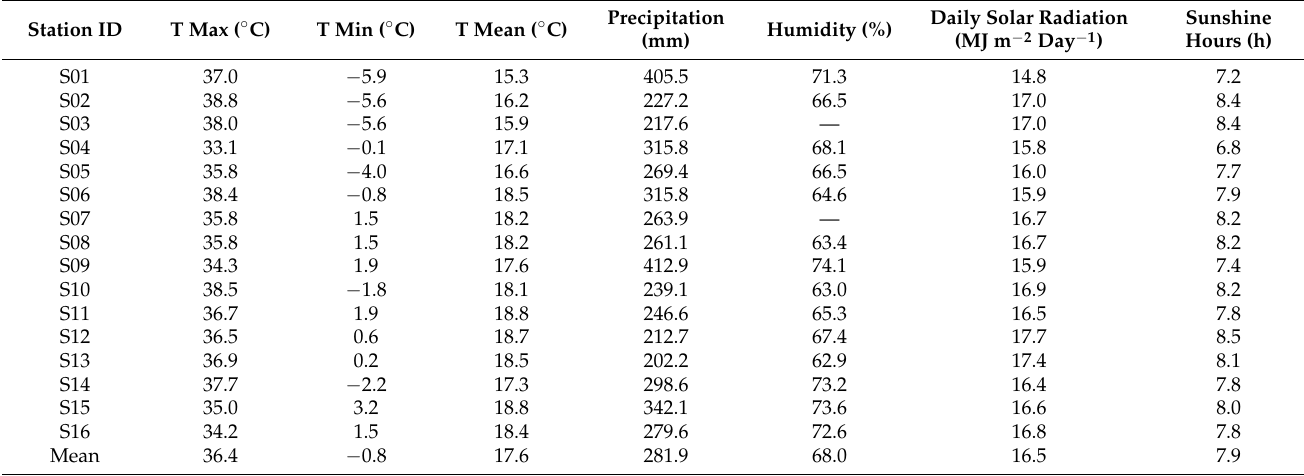
Table 2. Annual meteorological averages of some variables at each study